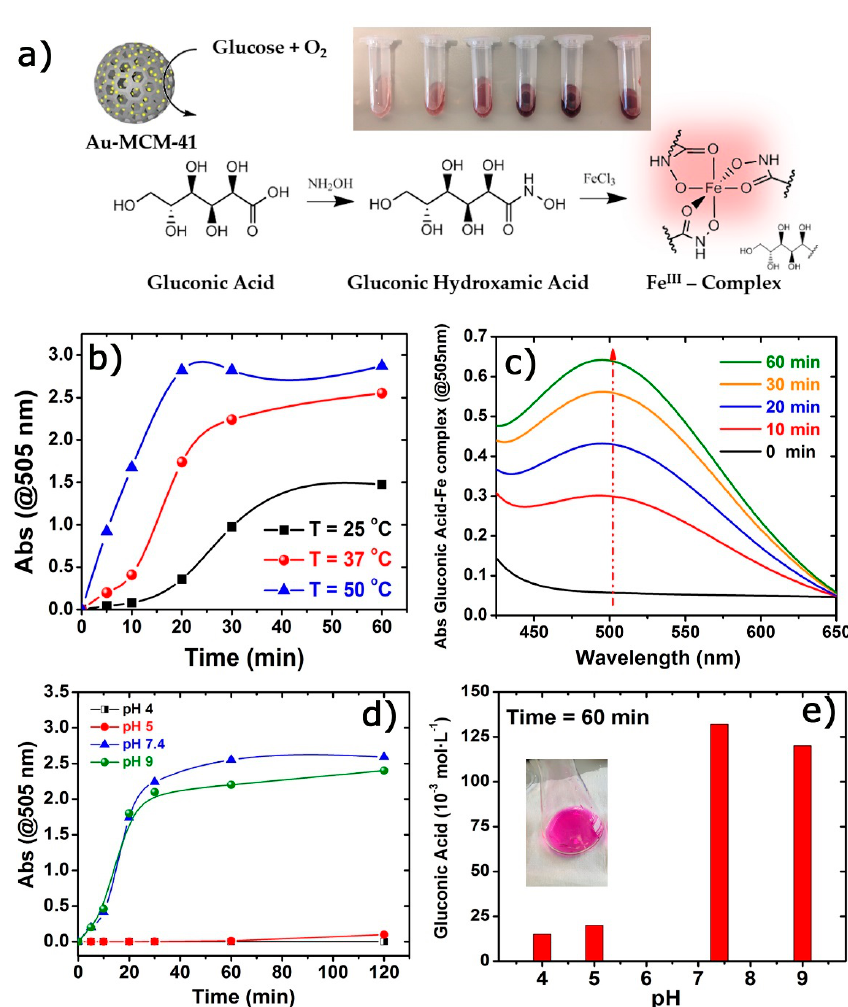
Figure 2. Determination of the presence of gluconic acid as one of the expected products retrieved from the oxidation of glucose in the presence of the enzyme-like gold-silica nanocatalyst: ( a ) Schematic display of the reaction of gluconic acid with hydroxylamine and trivalent Fe salt to form a red colored Fe-hydroxamate complex with a maximum absorbance centered at 505 nm (inset: digital image showing the evolution of the red-colored vials upon increasing reaction times related to increasing formation of gluconic acid); ( b ) Comparison of the maximum absorbance detected at different time intervals with different reaction temperatures and neutral pH = 7.4; ( c ) Representative UV-Vis spectra of the Fe-complex exhibiting an increase in the maximum absorbance centered at 505 nm after different reaction time intervals; ( d ) Comparison of the maximum absorbance detected at different time intervals and different pH conditions (temperatures fixed at 37 °C); ( e ) Concentrations of gluconic acid determined after colorimetric titration with NaOH and phenolphthalein as indicator (inset: digital image of the final color obtained after completing the neutralization of the gluconic acid with NaOH using phenolphthalein as colorimetric indicator). Experimental conditions: [catalyst] = 0.025 mg/mL; [glucose] = 150 mM; reaction media buffered with 0.2 M sodium acetate/acetic acid. Titration experiments were carried out using titration controls with known concentrations of commercial gluconic acid at pH adjusted to 4.